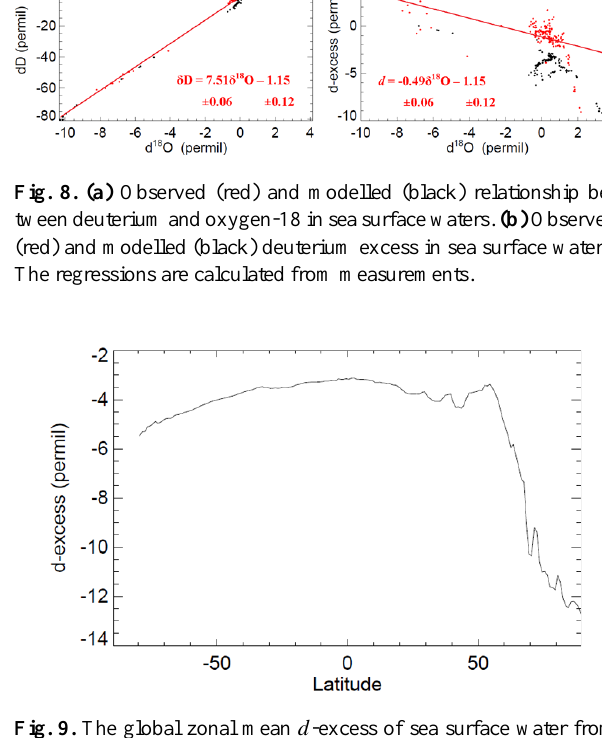
Fig. 9. The global zonal mean d -excess of sea surface water from MPI-OM simulation.